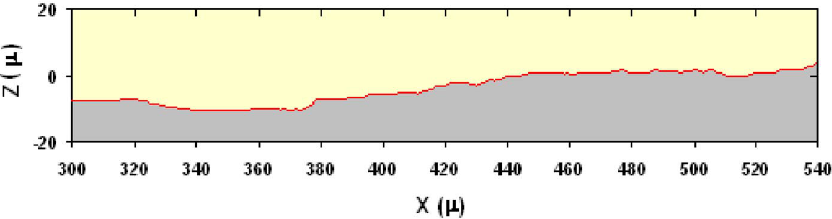
FIG. 7. (Color) Portion of the Fig. 6 RHIC beam pipe surface profile shown here with equal X and Z